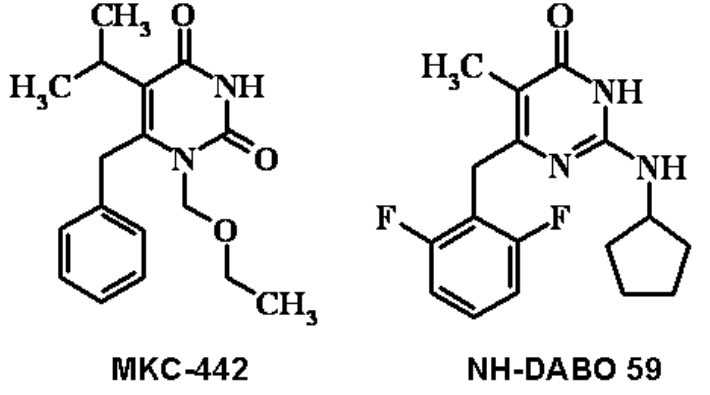
Figure 2. Structures of MKC-442 (template) and the most potent NH-DABO 59